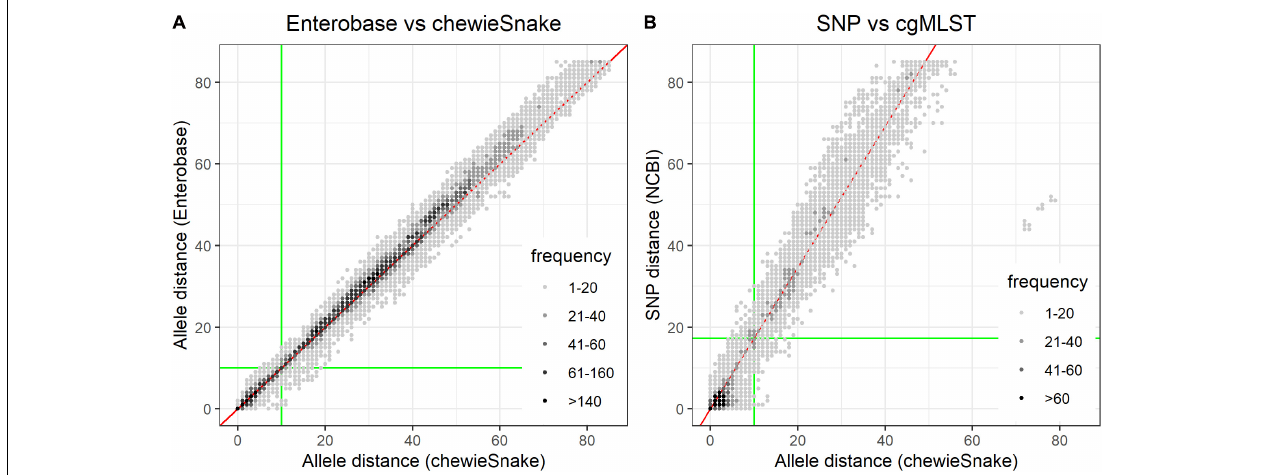
FIGURE 3 | Pairwise distances show very high method congruence. (A) Comparison of allele distance between Enterobase and chewieSnake . (B) Comparison of NCBI_pathogen SNP and chewieSnake allele distance. The gray shading indicates the frequency of observed pairwise distances. Both figures show the very high concordance between the different methods. This is also reflected in the Spearman correlation coefficients (0.984 and 0.973). The slope of a linear fit (red line) to the NCBI_SNP and chewieSnake comparison is ∼ 1.73; i.e., on average, 1 allele difference corresponds to 1.73 single-nucleotide polymorphisms. For the computation of sensitivity and specificity, the green lines mark clustering thresholds. All points in the lower left quadrant are counted as true positives, and all points in the upper right quadrant as true negatives, whereas the points in the top left and bottom right quadrants are false positives and false negatives, respectively. Using these thresholds also leads to the high adjusted Wallace and adjusted Rand coefficients (see Tables 1 , 2 ). Though overall the agreement is very high, some remaining differences at low distances may still influence interpretation of the very fine-grained phylogeny. Note that for the Enterobase comparison, only distances below 85 AD were